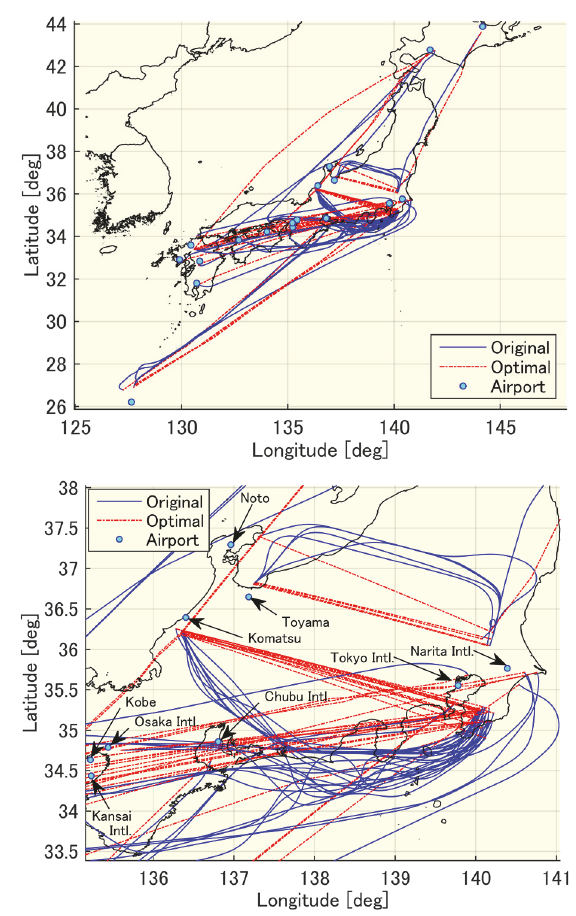
Figure 14: Flight path with long detour (all aircraft types); below figure is